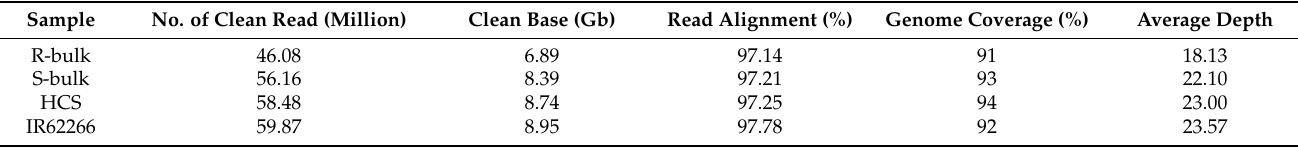
Table 1. Summary of the Illumina sequencing data and mapping statistics of the parental lines and the resistant (R) and susceptible (S)